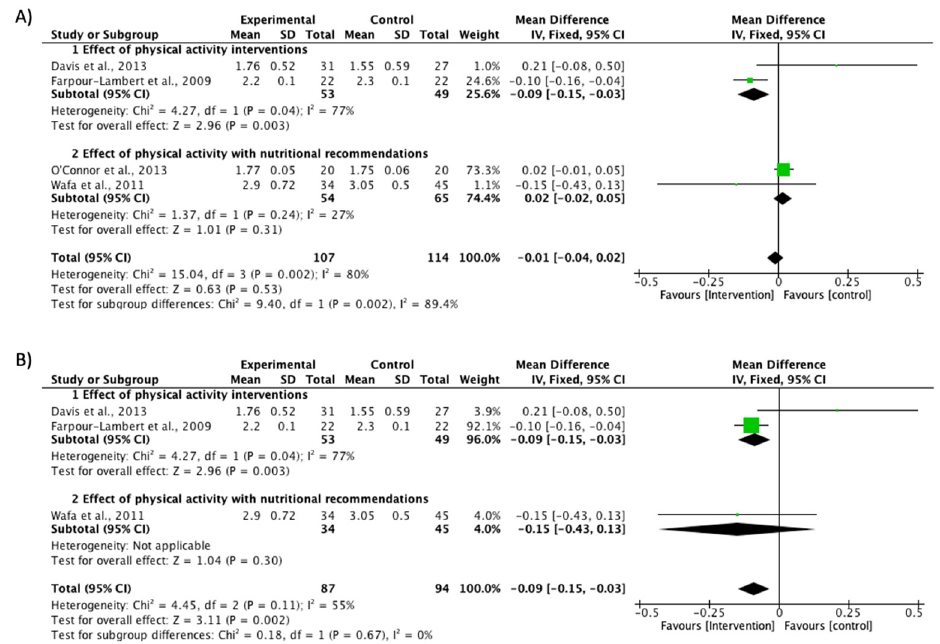
Figure 3. Effect interventions on BMI Z-score reduction in studies only including children with obesity. ( A ) BMI Z-score values forest plot. ( B ) Sensitivity analysis of BMI Z-score forest plot (O’Connor et al. [32] study not included). CI, confidence interval.